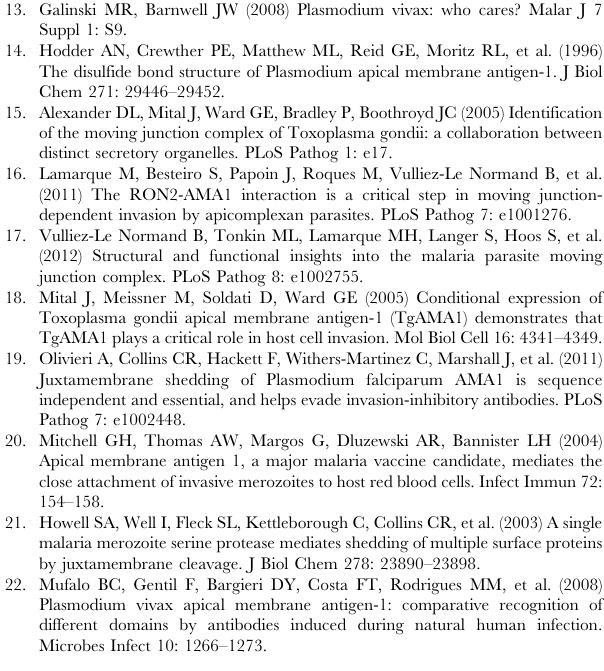
indicates residues that are polymorphic in both species [77]. The domain boundaries are demarcated by vertical lines, as indicated. clusters, c1-3 [66]; Grey shading indicates antigenic escape residues in c1L [38]. Figure S3 Natural selection within Pvama1 for isolates from Venezuela and Thailand. Sliding window analysis of Tajima’s D was performed for the Venezuelan 1997 population (i), the two Thai Tak province populations (ii; the solid line represents the Tak 1996 population and the dashed line represents the Tak 2007 population) and the Thai Chanthaburi population (iii). A window size of 100 and a step size of 3 were used. Horizontal dashed lines indicate the significance threshold (p= 0.05); a single asterisk indicates values for which p , 0.05. Figure S4 Worldwide distribution of Pv AMA1 40-mer haplotypes. Based on the analysis of the 40 NS amino acid polymorphism haplotypes, pie charts depicting the relative frequencies of the 219 haplotypes identified were drawn for each parasite population. Coloured segments indicate haplotypes that are present in more than one population; grey indicates haplotypes present in only one population. Only one haplotype was identical to reference strains ( Belem/Palo Alto ), therefore haplotypes from the remaining reference strains are shown in grey. Sample size and origin are indicated. Figure S5 Cluster membership of the P. vivax reference strains. Haplotypes analysed using the program S TRUCTURE [61,62] were found to be optimally distributed among eleven clusters ( K =11). Colours indicate the proportion of each reference